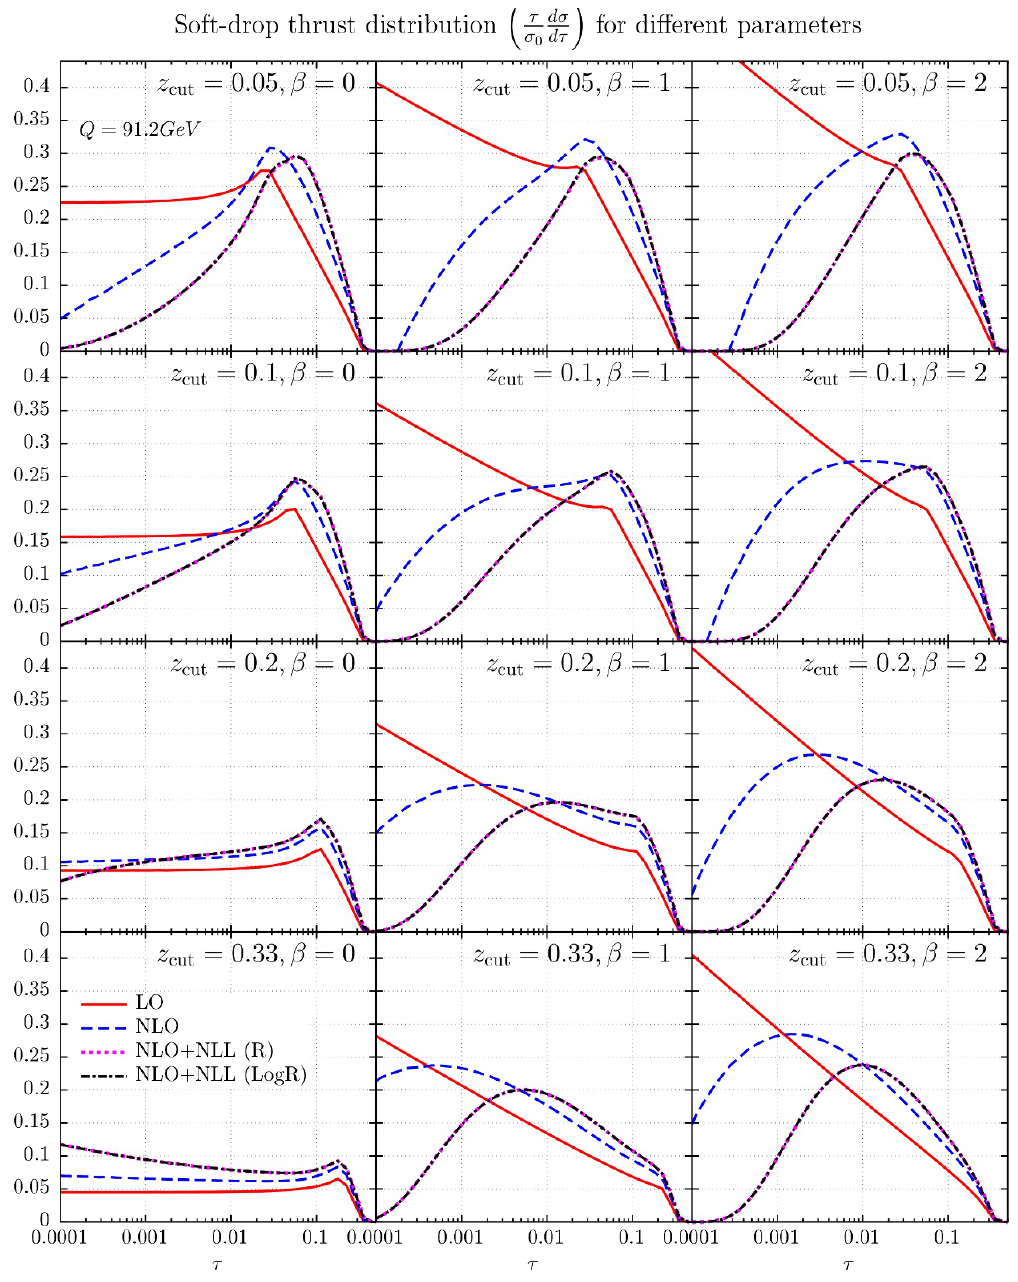
Figure 1. The di(cid:11)erential cross section for the analytical soft-drop thrust distribution at LO (solid red), NLO (dashed blue) and NLO+NLL with both multiplicative (dotted magenta) and LogR (black dashed-dotted) matching.